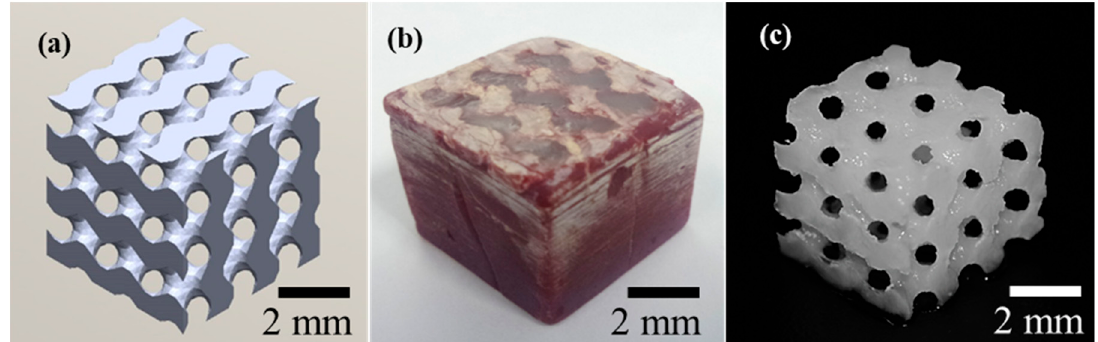
Figure 5. Fabricated cellulose hydrogel with Schoen gyroid structure using Solidscape ® wax, channel diameter of 1 mm: ( a ) CAD design of network gyroid with 1-mm channel size, ( b ) gyroid wax mould template filled with cellulose solution and gelled and ( c ) cellulose hydrogel after wax removal.